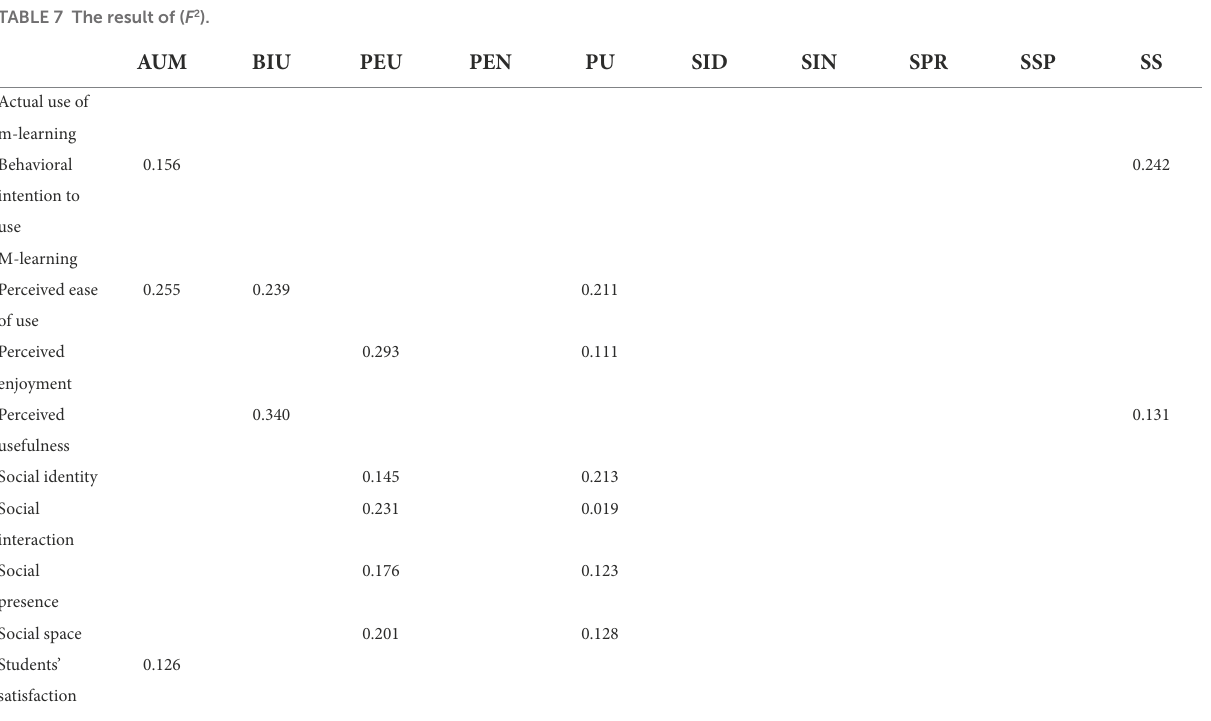
TABLE 7 The result of ( F 2